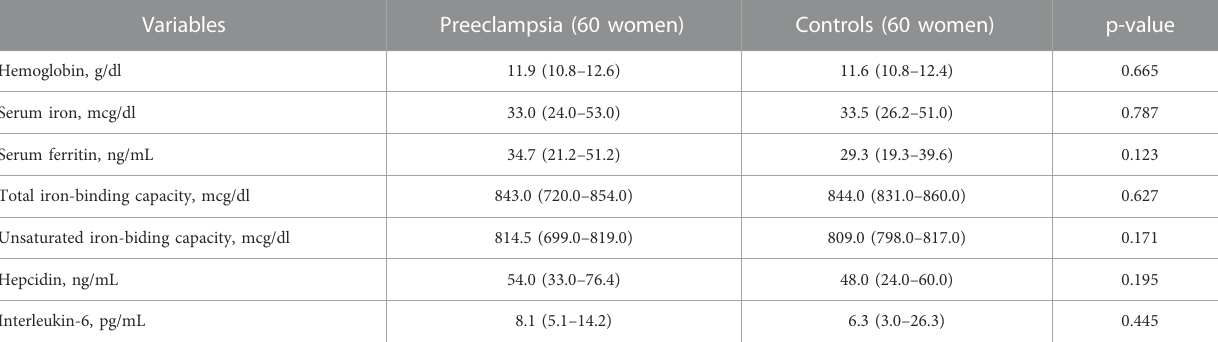
TABLE 2 Comparing the median (interquartile range) of the iron status indices, hepcidin, and interleukin-6 between women with preeclampsia and controls in Khartoum Sudan, 2020.